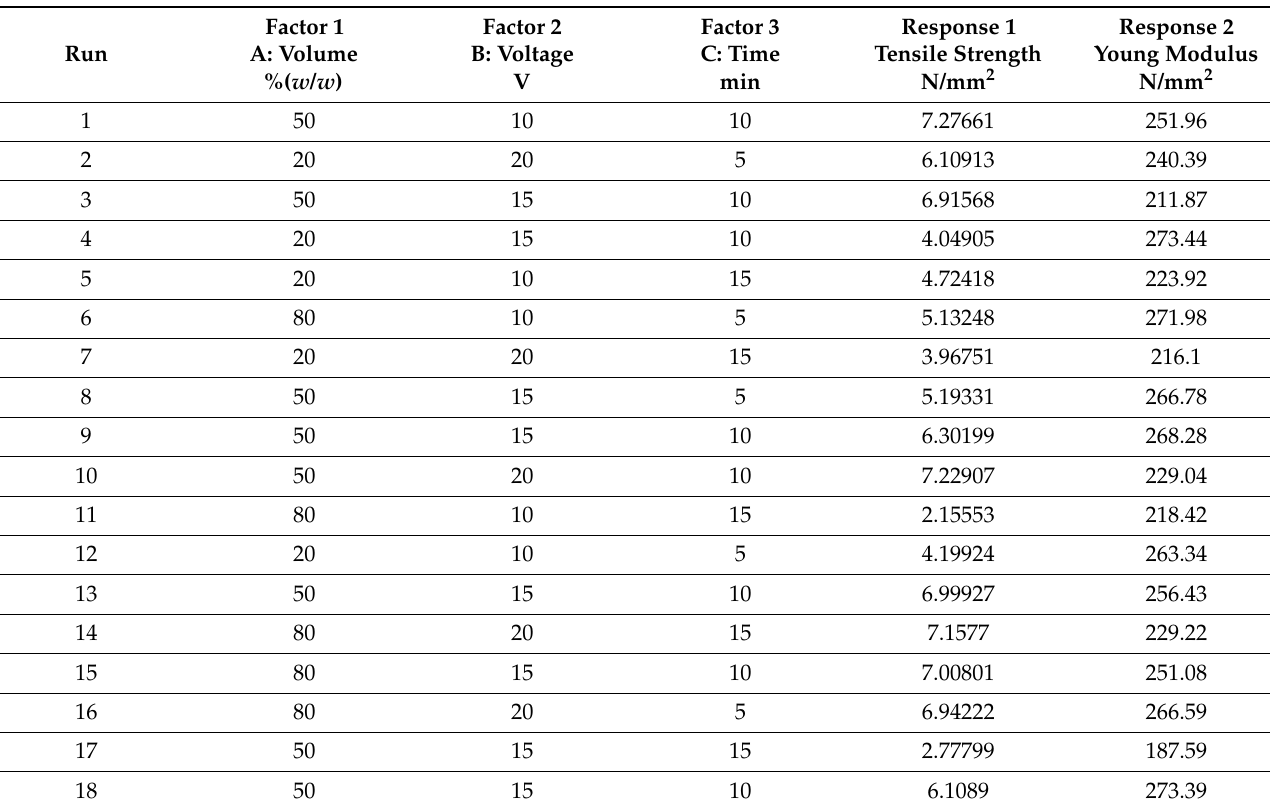
Table 8. Tensile strength and Young’s Modulus of CNT–CF/epoxy composites with different factor values for 20% and 80%